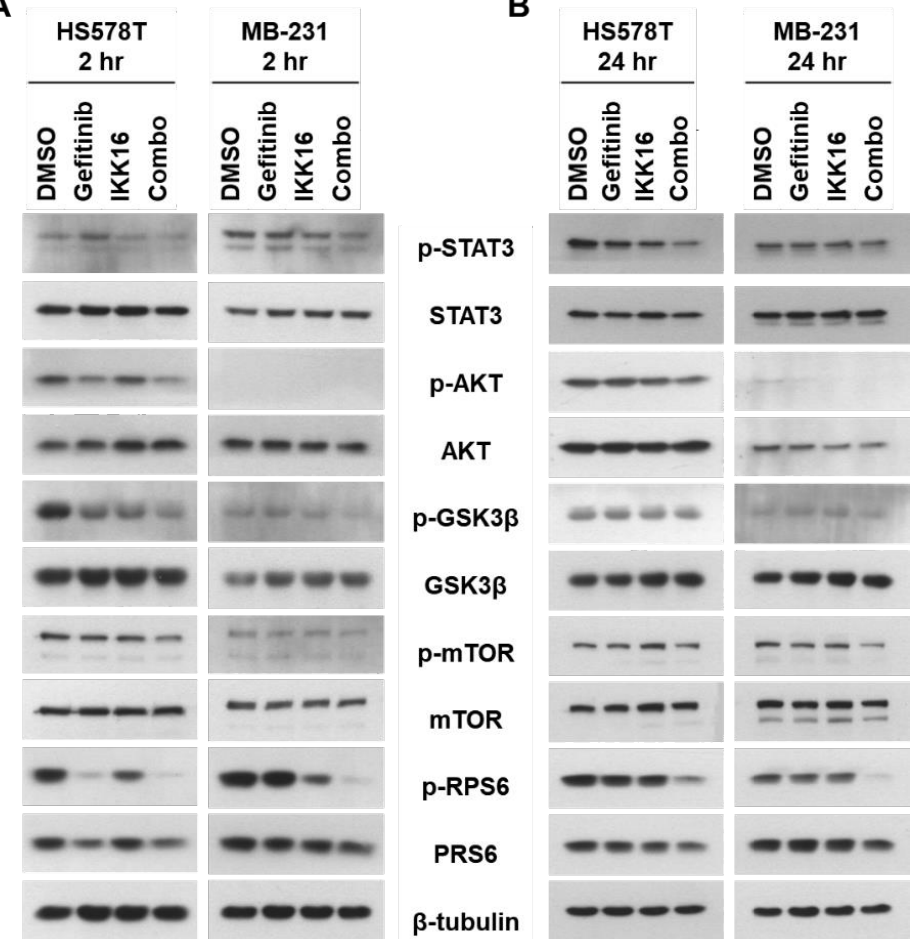
Figure 4. Inhibition of signaling pathways by the Gefitinib+IKK16 combination in TNBC cells. The cells were treated by drugs as indicated for 2 h ( A ) or 24 h ( B ), and the cell lysates were subjected to western blotting with antibodies against the proteins indicated. The β -tubulin was used as a loading control. Representative images were shown from three independent experiments.